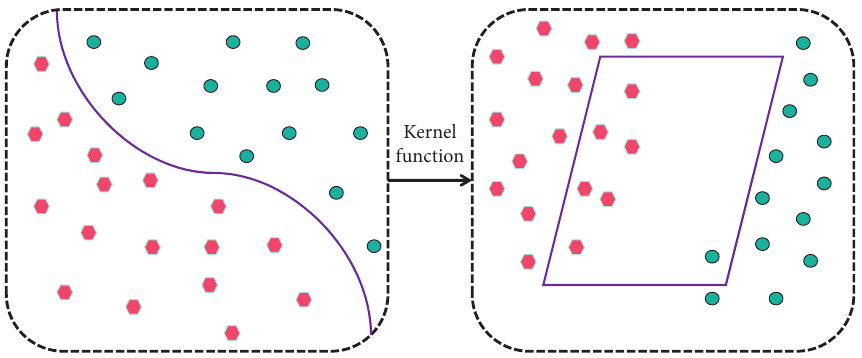
Figure 12: Nonlinear mapping in